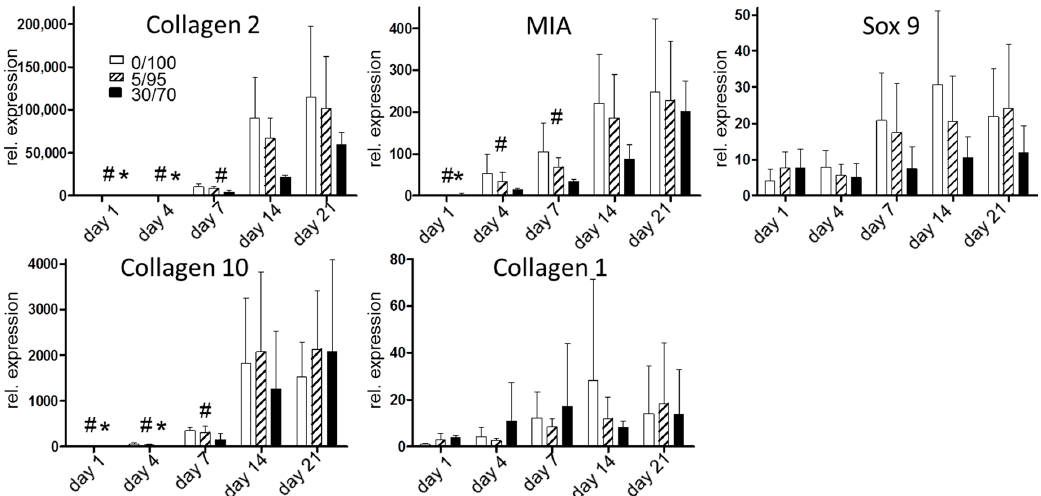
Figure 4. Gene expression analysis during chondrogenic differentiation for chondrogenic differentiation markers (upper row) and markers of hypertrophy (Collagen 10) and fibrous differentiation (Collagen 1) (# p < 0.05 for all groups compared to day 21, * p < 0.05 for all groups compared to day 14). Rel. gene expression = compared to mean gene expression of housekeeping genes.